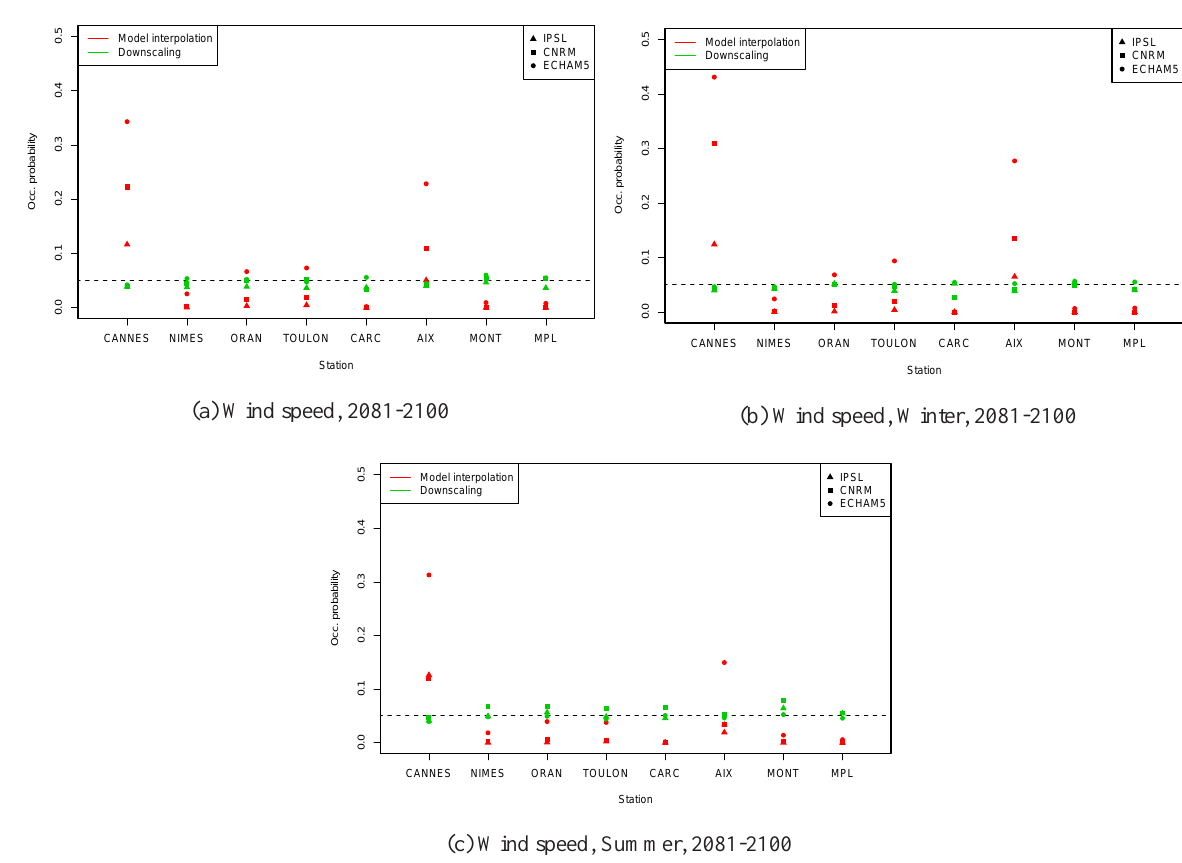
Fig. 9: Same figure as Fig. 7 for the strongest wind speed. Table 5. Rainfall occurrence obtained from interpolated GCM rainfall over the 1981–2000 calibration period (columns 2 and 4) and the 2081–2100 projection period with the A2 scenario. Columns 2 and 3, and 4 and 5 correspond to processing 1 (non-zero precipitation) and processing 2 (threshold precipitation), respectively. The values in brackets correspond to probabilities computed from CDF-t